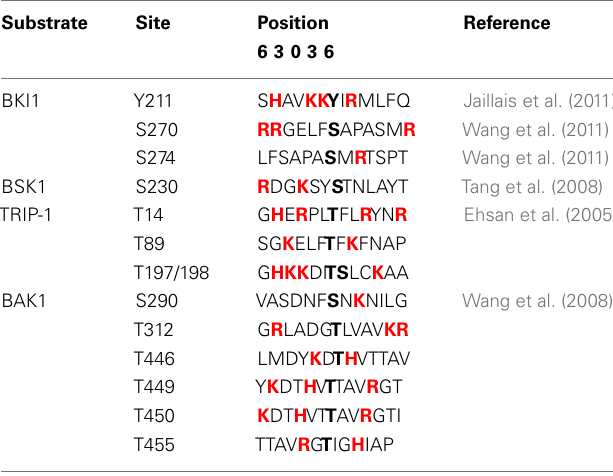
Table 4 | Potential BRI1-mediated transphosphorylation sites in Arabidopsis substrate